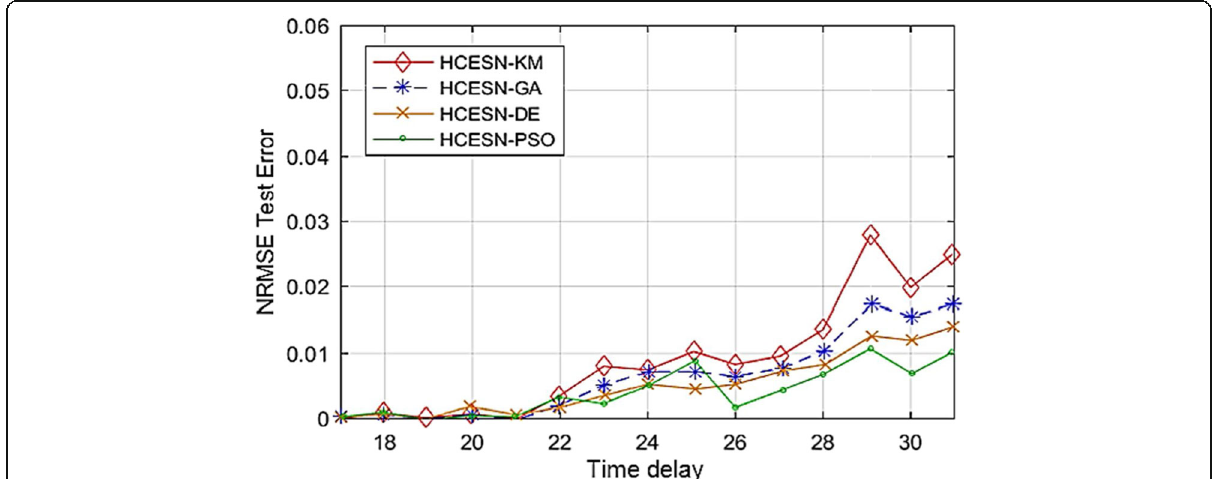
Fig. 8 The NRMSE test error against time-delay δ for HCESNs in MG